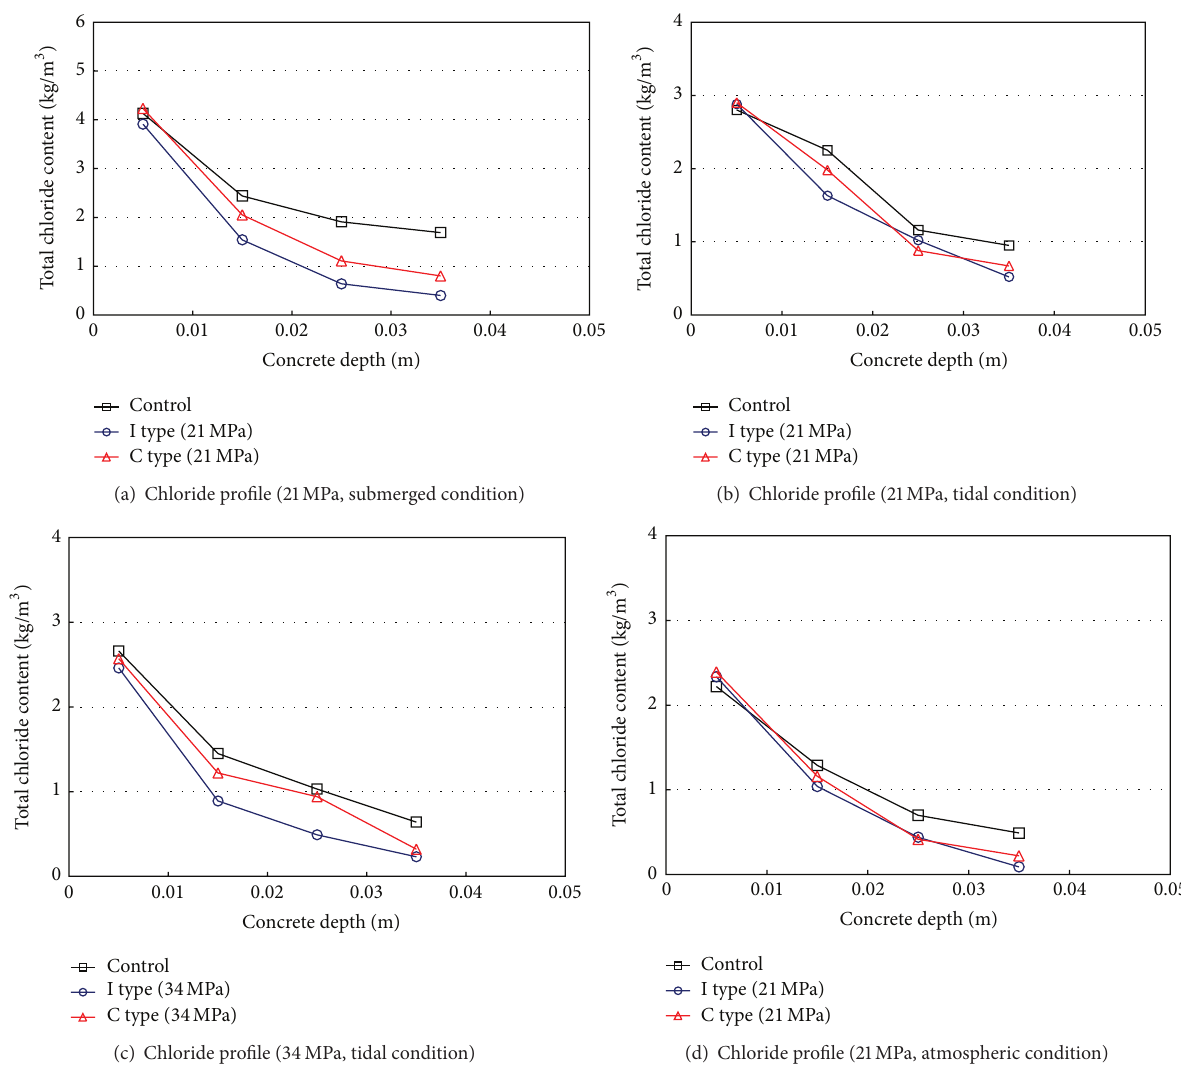
Figure 8: Total chloride profile in concrete with/without impregnation after 2